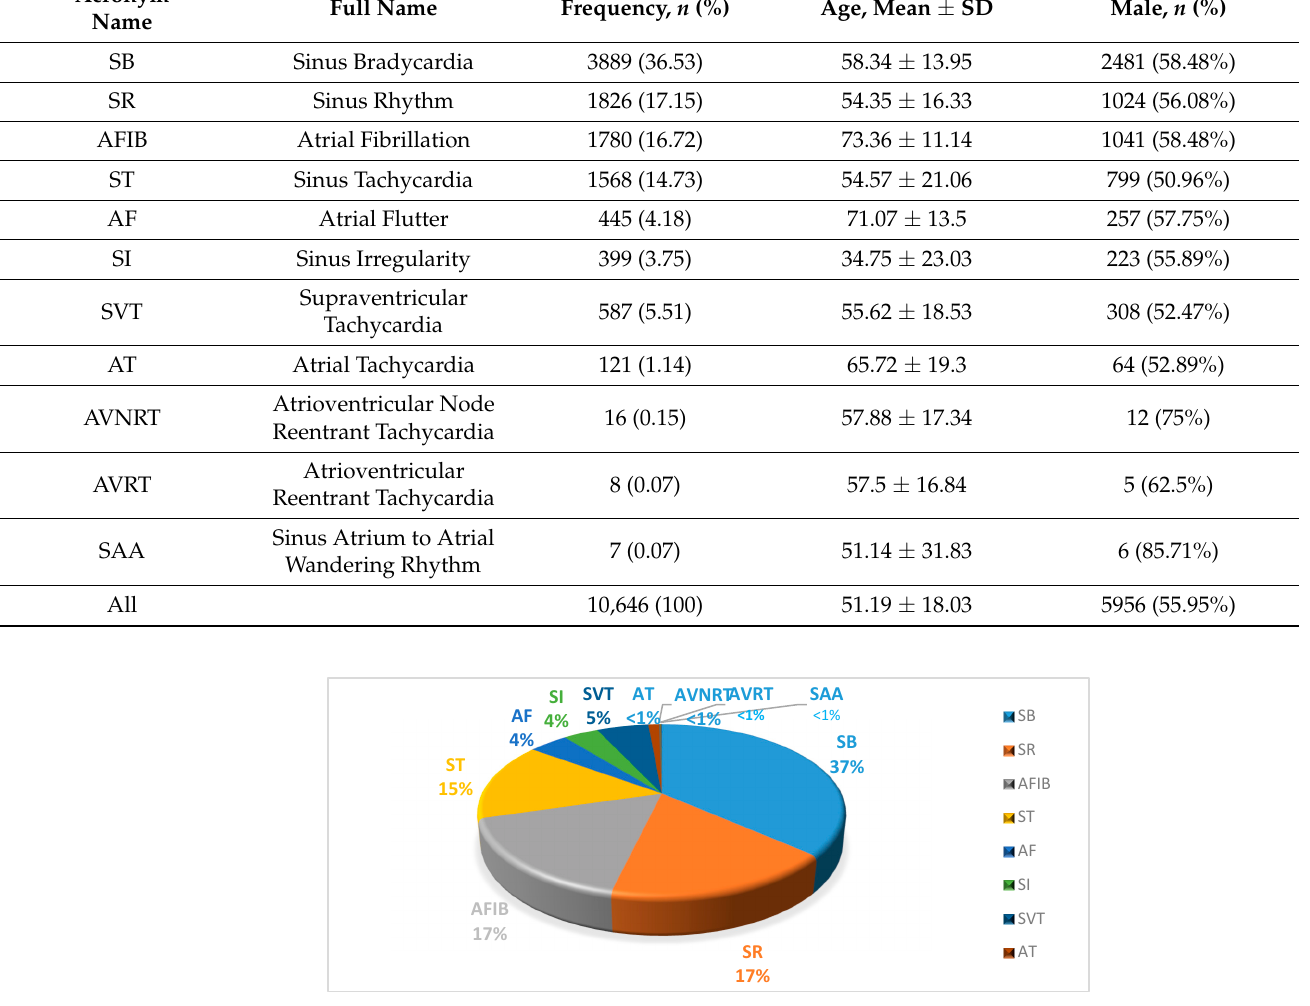
Table 1. Rhythm information and basic characteristics of the participants.